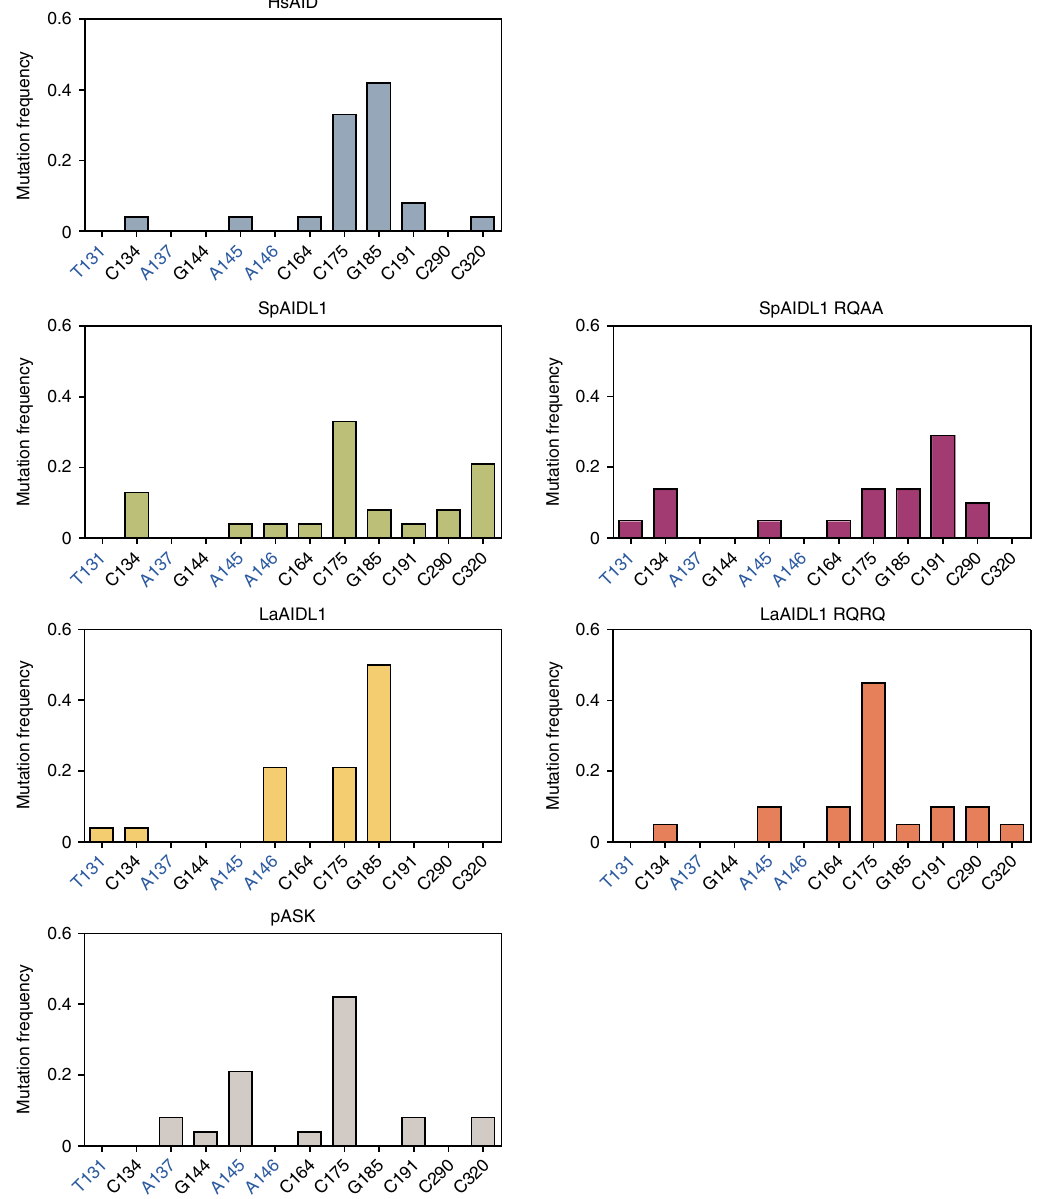
Fig. 4 Mutation patterns generated by SpAIDL1 and LaAIDL1. Genomic DNA fragments of the rpoB gene from 24 individual Rif R colonies from the E. coli - based deaminase assay (Figs. 3, 5) were ampli fi ed by PCR and sequenced. For each deaminase a minimum of 20 interpretable sequences were obtained (HsAID: 24, SpAIDL1: 24, SpAIDL1 RQAA: 21, LaAIDL1: 24, LaAIDL1 RQRQ: 20, pASK: 24). The frequencies of mutations at individual nucleotides numbered relative to the 5 ′ -end of the PCR product (with A/Ts shown in blue) are shown as bar graphs. Colonies from bacteria containing only the empty expression vector (pASK) served as the negative control for spontaneously arising mutations conferring resistance to